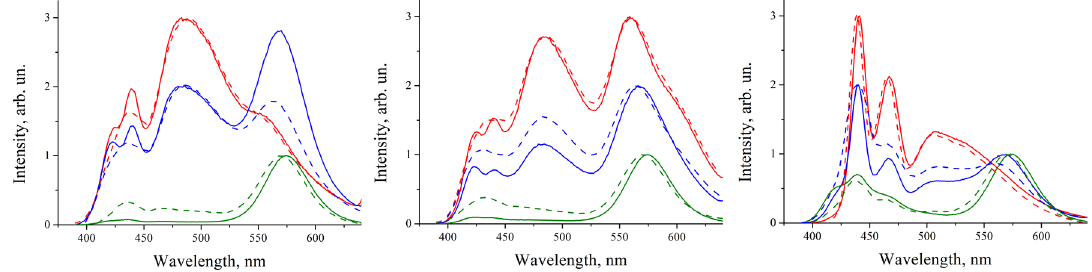
Figure 4. Luminescence spectra of the QD–p79 ( A ), QD–p99 ( B ), and QD–p133 ( C ) composites at various QD-to-polymer concentration ratios, measured immediately after fabrication (solid lines) and after a week of storage under normal conditions (dashed lines). The QD-to-polymer concentration ratios are 1:10 (red), 1:1 (blue), and 10:1 (green).